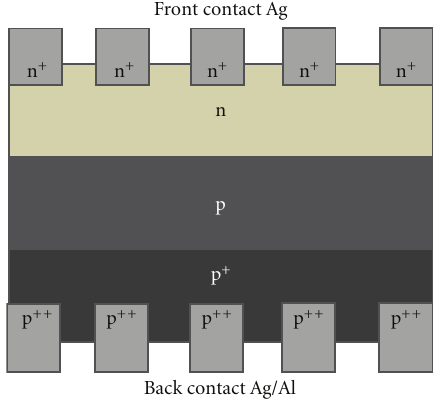
Figure 1: Bifacial solar cell with n+pp+